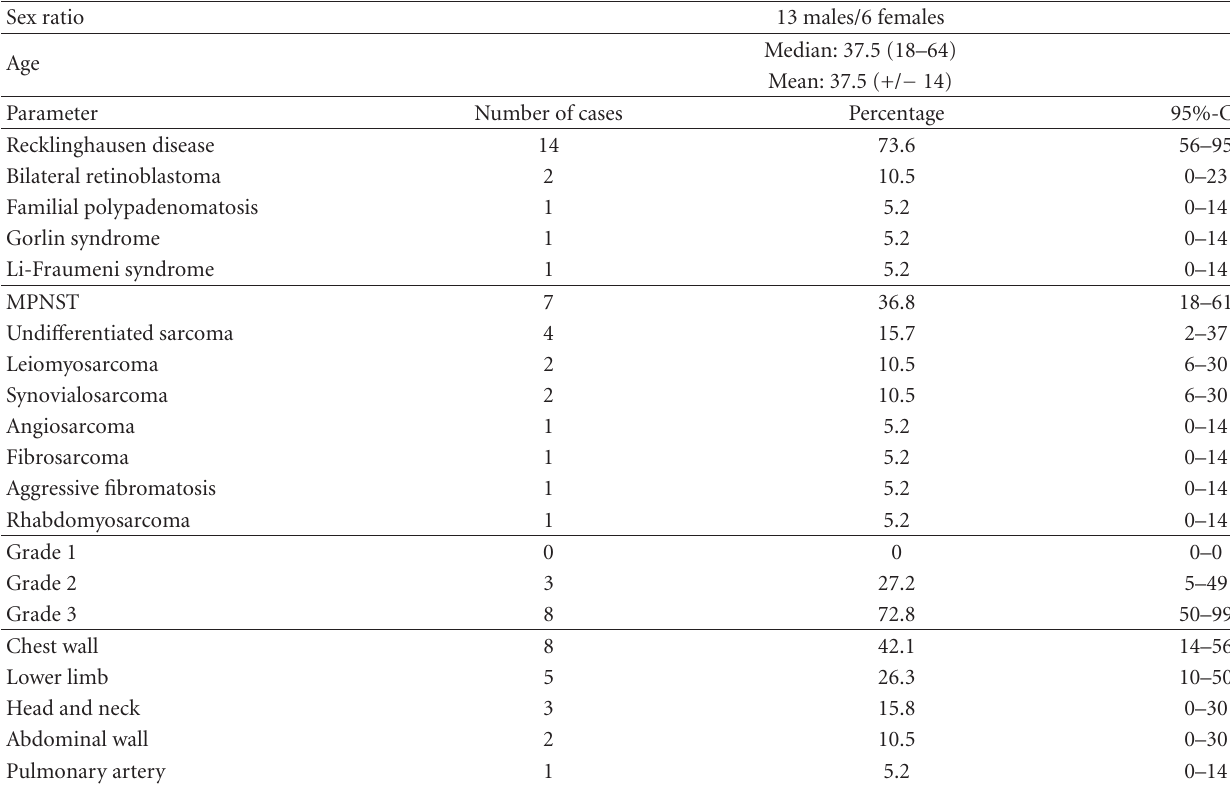
Table 2: Sarcomas associated with genetic